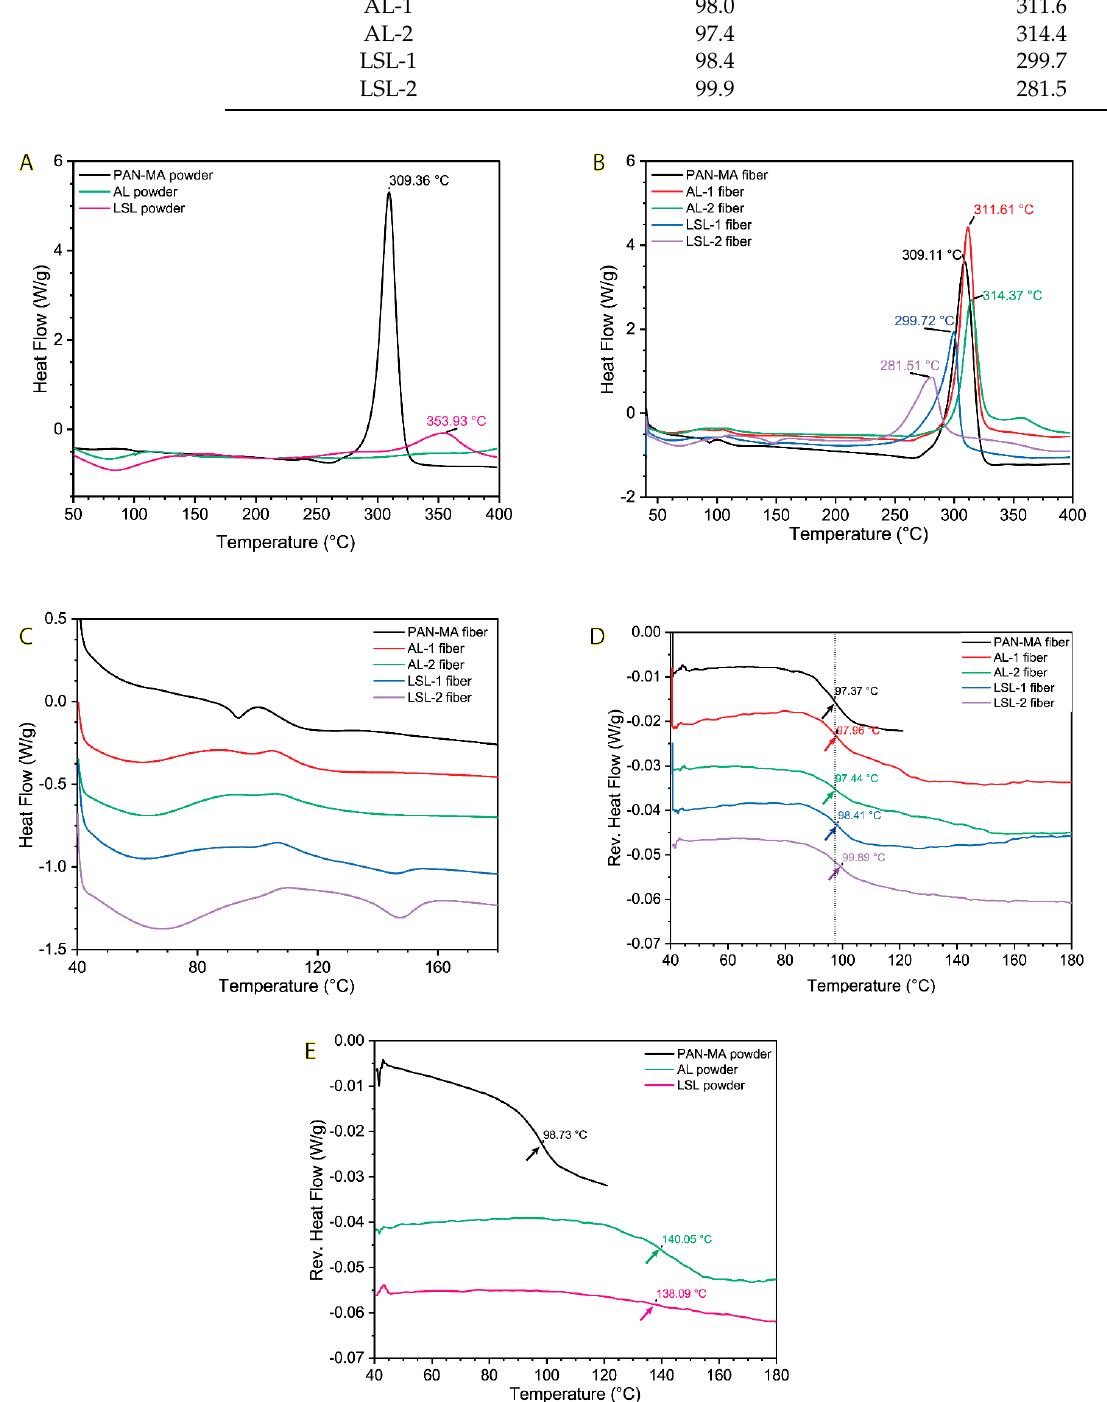
Figure 8. ( A ) DSC results for powder samples, ( B ) DSC results for fiber samples, ( C ) close − up of DSC results for fiber samples in Tg range, illustrating difficulty of assigning Tg values, ( D ) MDSC results for fiber samples, with clear glass transitions, and ( E ) MDSC results for powder samples.